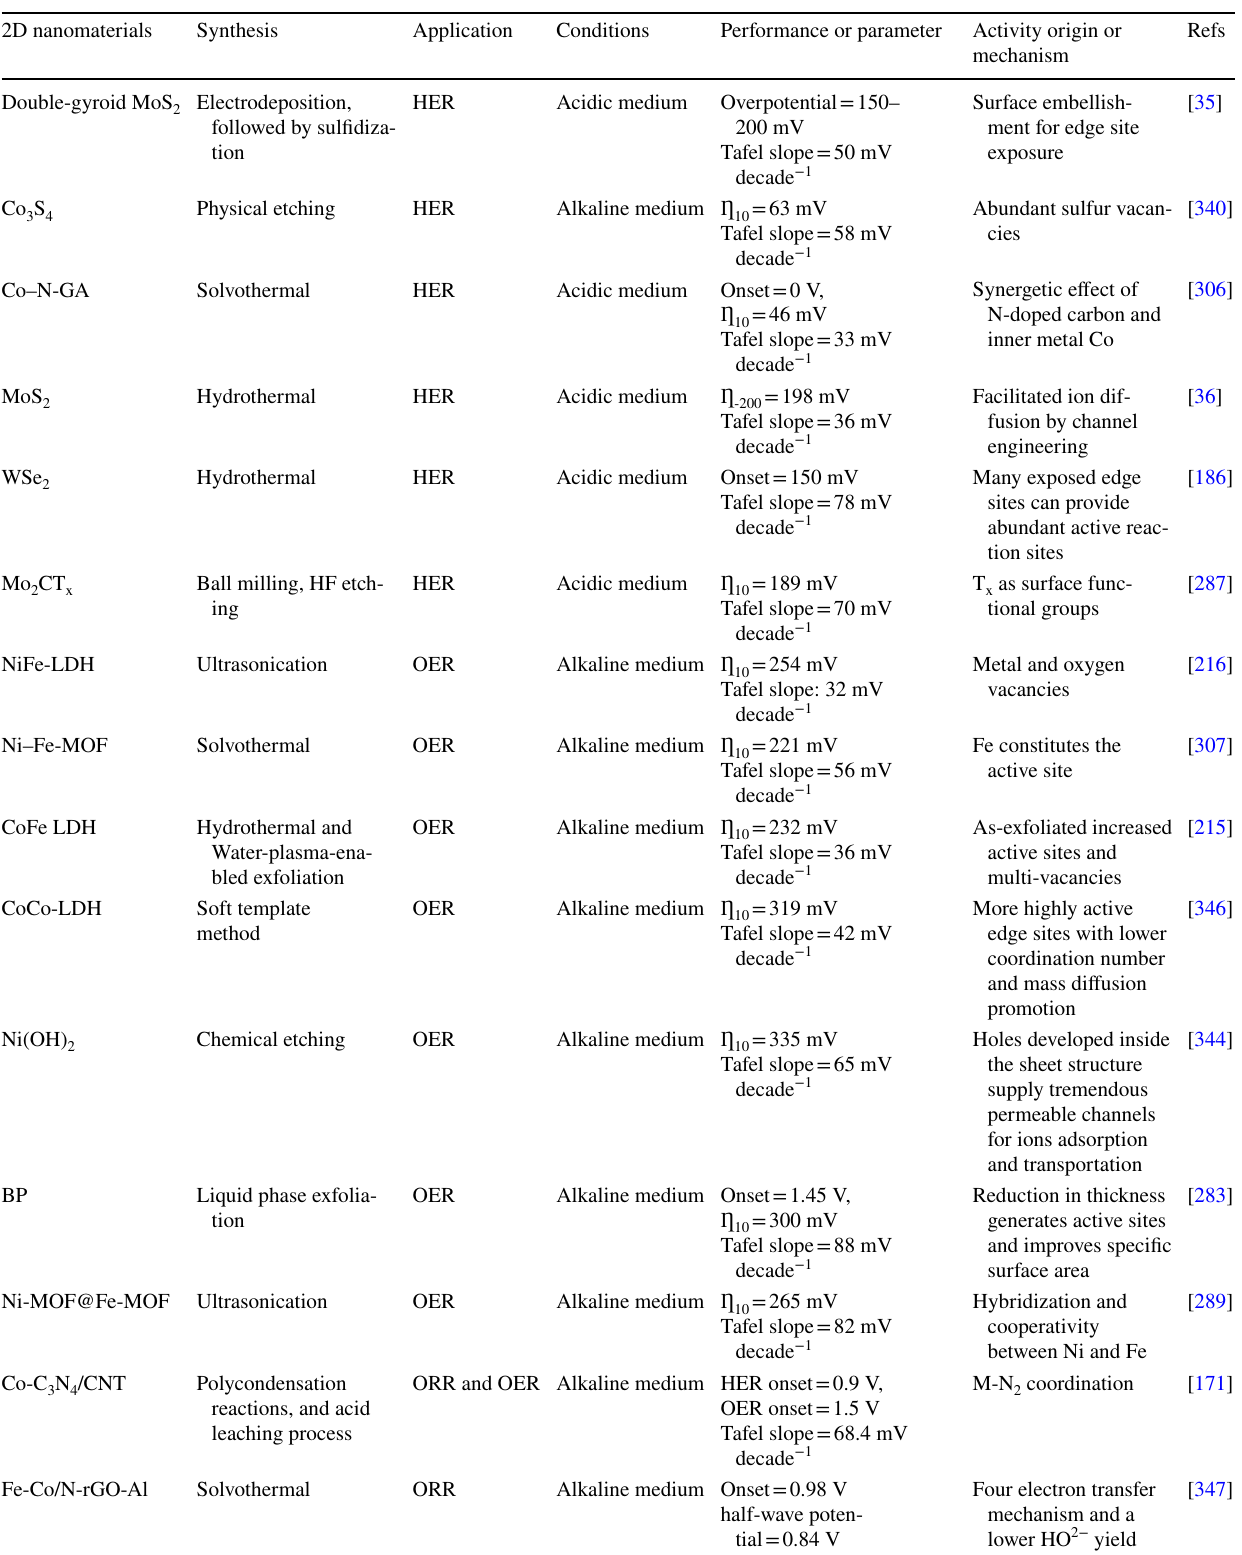
Table 2 Overview of range of 2D nanomaterials for electrocatalytic applications 2D